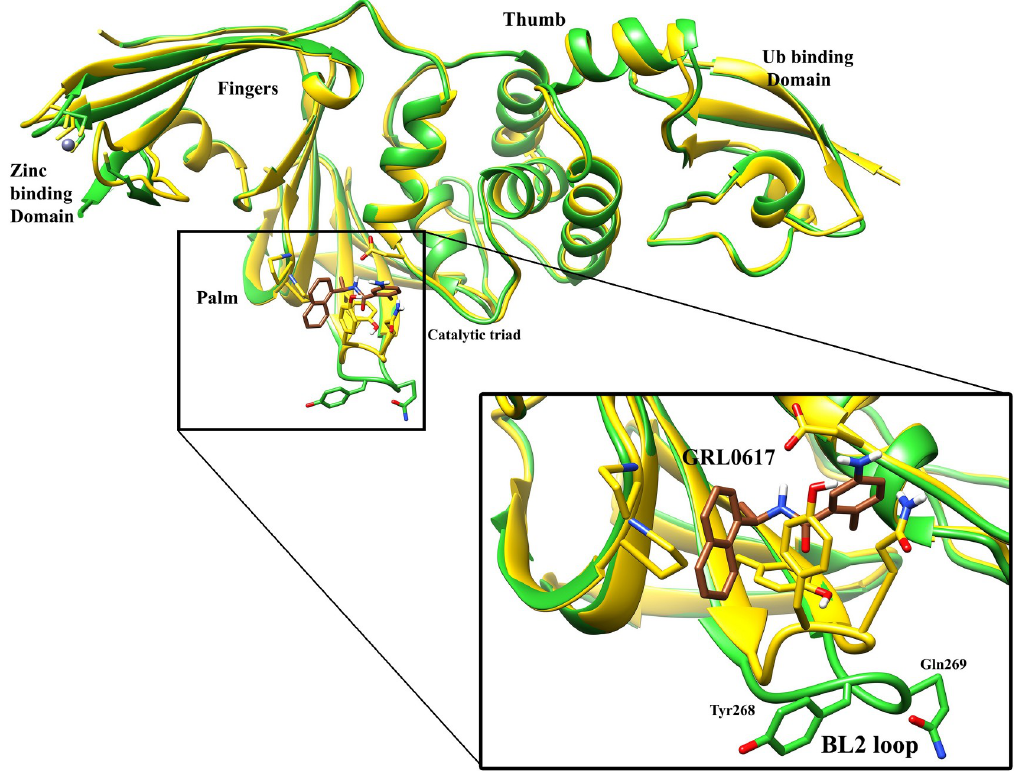
Fig 1. Structure of SARS-Cov-2 Plpro enzyme. The superimposed crystallographic structures of the apo form (PDB ID: 6W9C), colored in green, and the complexed form of SARS-CoV-2 Plpro in complex with GRL0617 (PDB ID: 7CMD) [34] colored in yellow. The sequence from Thr266 to Gly272 is considered as the BL2 loop.